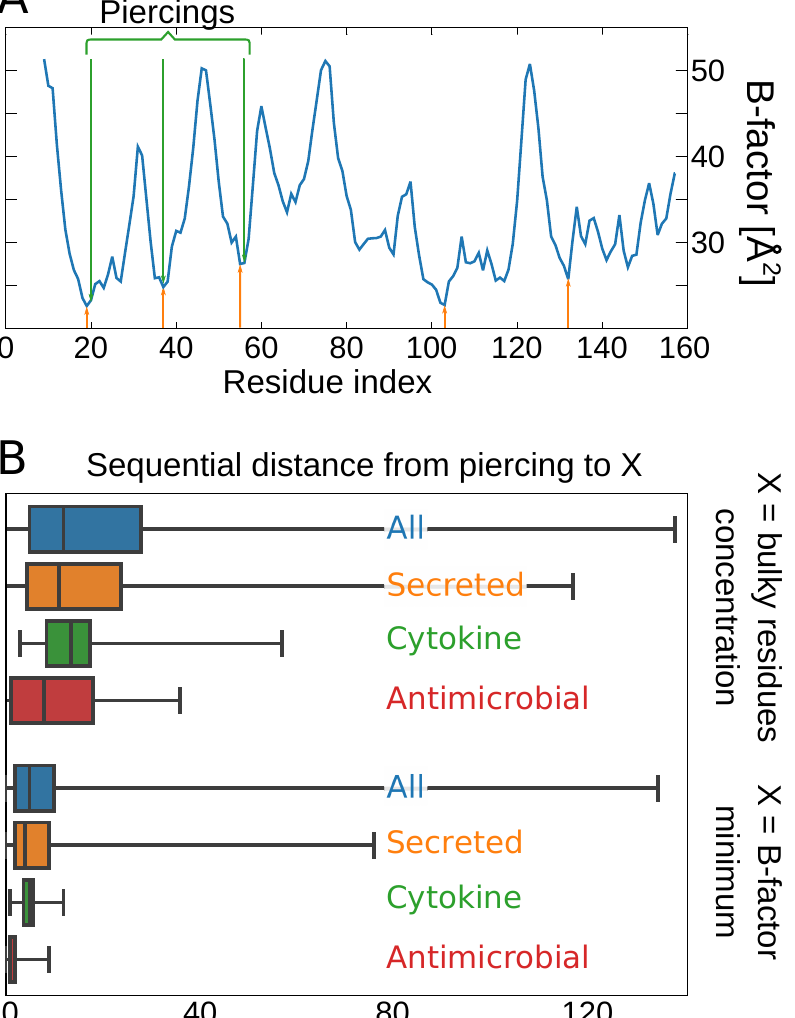
Figure 8. Quantifying lasso stabilization. ( A ) Comparison of the locations of piercings (green arrows) and minima of the B-factor (orange arrows) for lipocalin with PDB code 1A3Y. ( B ) Box plots of the mean distance from the local maximum of the bulky residues concentration and the mean distance from the local B-factor (or mean square deviation in the case of NMR structures) maximum. White dots represent the mean value of each protein family set. Box widths represent 1st-3rd quartile range with the horizontal line showing the 2nd quartile